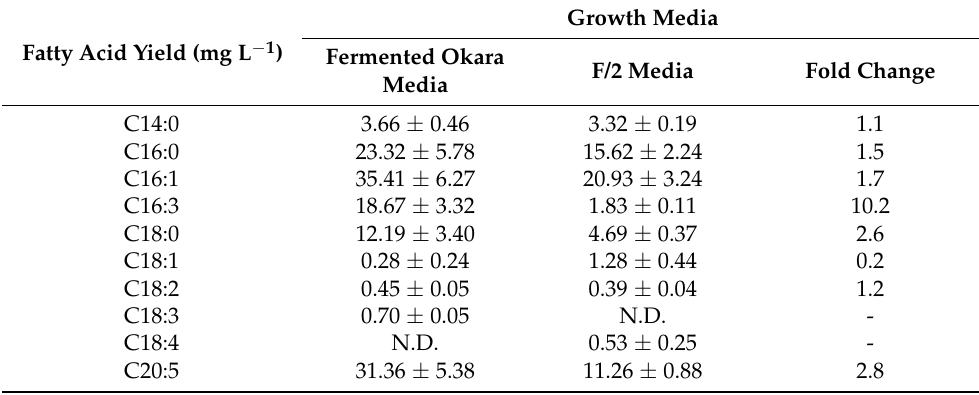
Table 3. Fatty acid quantification in P. tricornutum cells from fermented okara media and F/2 media.